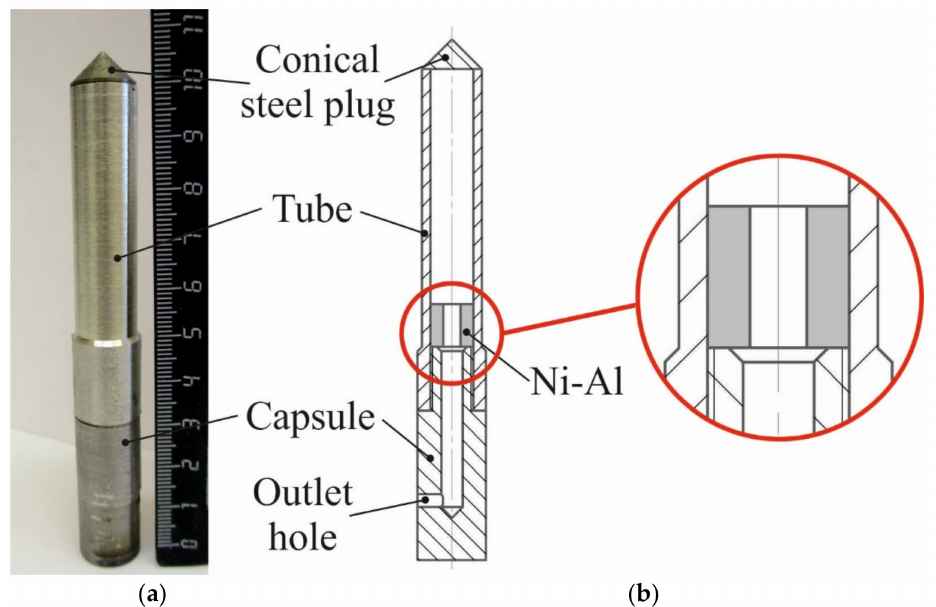
Figure 2. ( a ) Photograph of the cylindrical ampoule; ( b ) diagram of the cylindrical